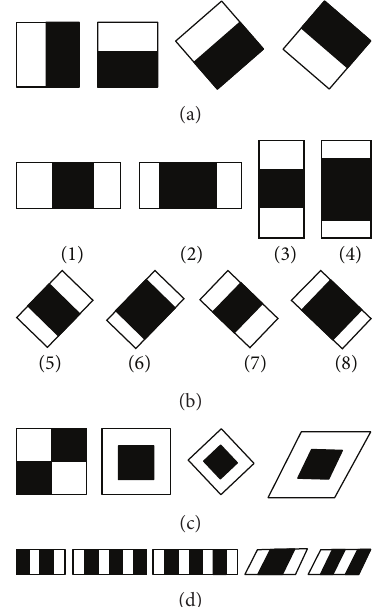
Figure 10: Haar-like prototypes used in our algorithm: (a) edge features, (b) line features, (c) center-surrounding features, and (d) plate character features.